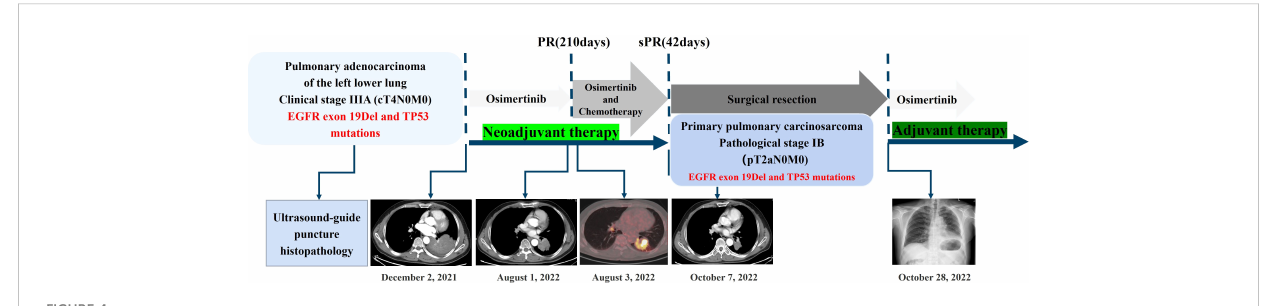
FIGURE 4 A summary of the treatment strategy employed in this